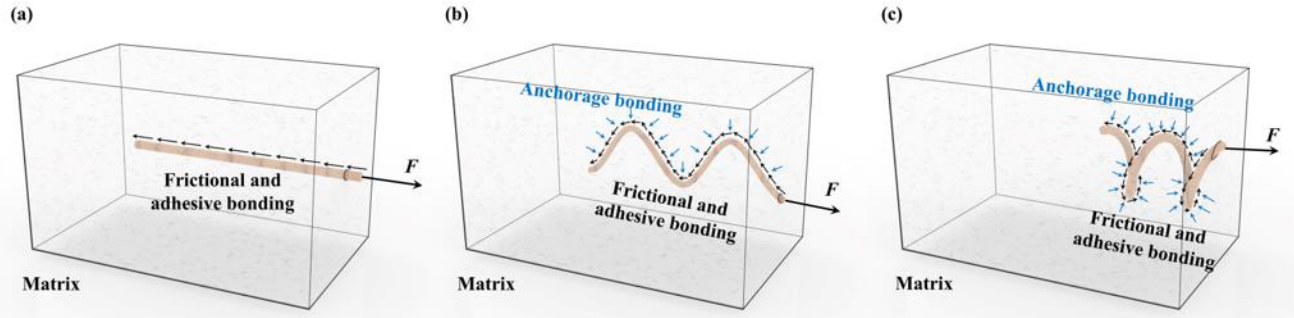
Figure 9. Anchorage bonding and frictional bonding between the fibers and the composite matrix: ( a ) straight fibers; ( b ) undulated fibers; ( c ) helical fibers.